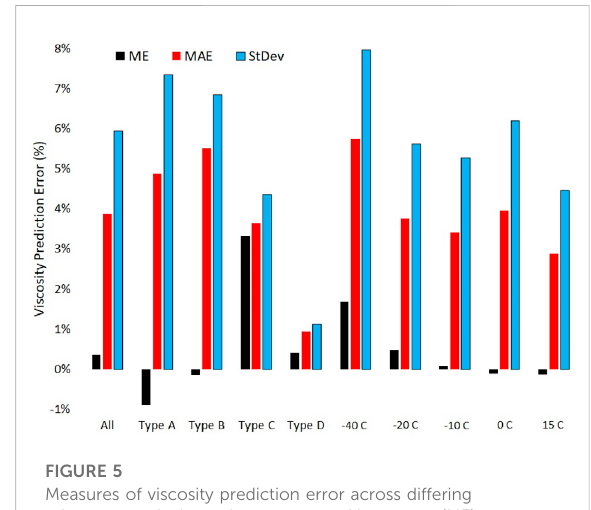
Measures of viscosity prediction error across differing mixture complexity and temperature. Mean error (ME), mean absolute error (MAE), standard deviation (StDev).